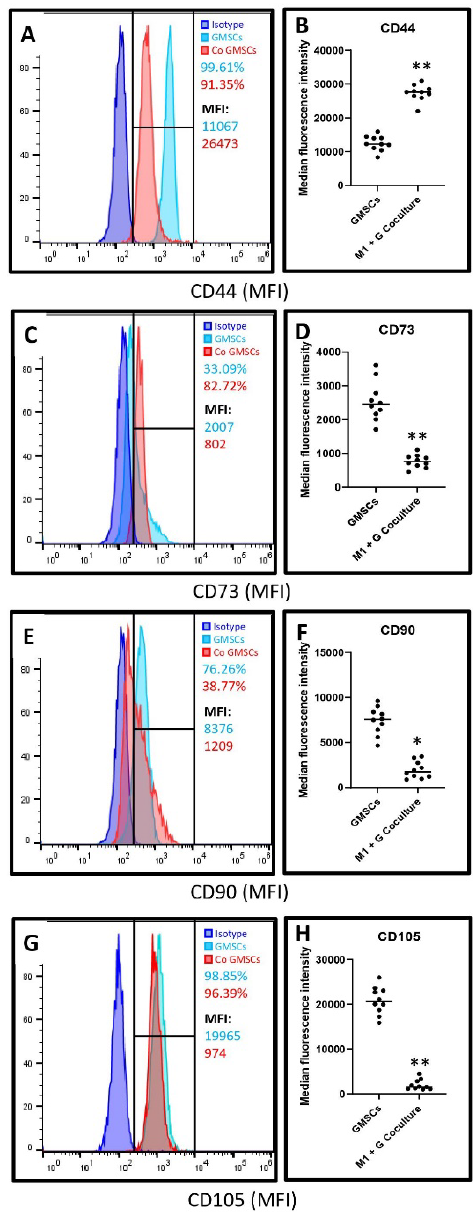
Figure 6. Histograms and comparative analysis depicting ( A , B )—CD44 (** p < 0.0001), ( C , D )—CD73 (** p < 0.0001), ( E , F )—CD90 (* p = 0.0456), and ( G , H )—CD105 (** p < 0.0001) staining intensity (median fluorescence intensity) in gingival stem cells and heterogeneous cell populations versus the gingival stem cells and heterogeneous cells co-cultured with macrophages. Gene expression of potential stemness markers, cytoskeletal proteins, epithelial extracellular matrix proteins, and cell adhesion molecule in untreated gingival cells versus gingival cells co-cultured with macrophages: Gene expression analysis was done on a wide range of genes, including stemness (OCT4 and NANOG), keratinocyte cytoskeletal proteins (KRT5 and KRT8), epithelial extracellular matrix proteins (COL3A1 and POSTN), epithelial cell-cell adhesion molecules (CDH1 and CDH3), and cell-surface adhesion molecules (ITGA6 and ITGB4) in untreated gingival cells versus gingival cells co-cultured with macrophages. Results revealed a significant downregulation of OCT4 and NANOG. KRT5, POSTN, COL3A1, CDH1, CDH3 genes in the co-culture versus control cells. There was no significant difference observed between the 2 groups concerning KRT8, ITGA6 , and ITGB4 gene expression. The relevant statistical data are presented in Figure 7A–J.